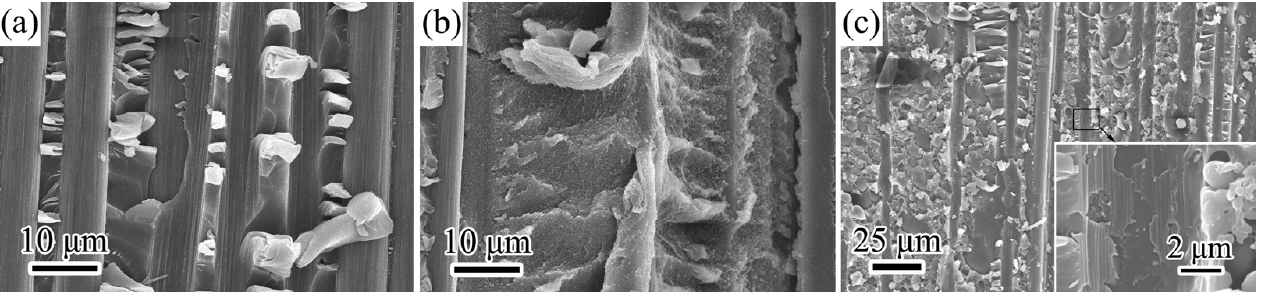
Figure 8. SEM images of the mode II fracture surfaces of ( a ) the control, ( b ) PS0-C, ( c ) PS100-C.